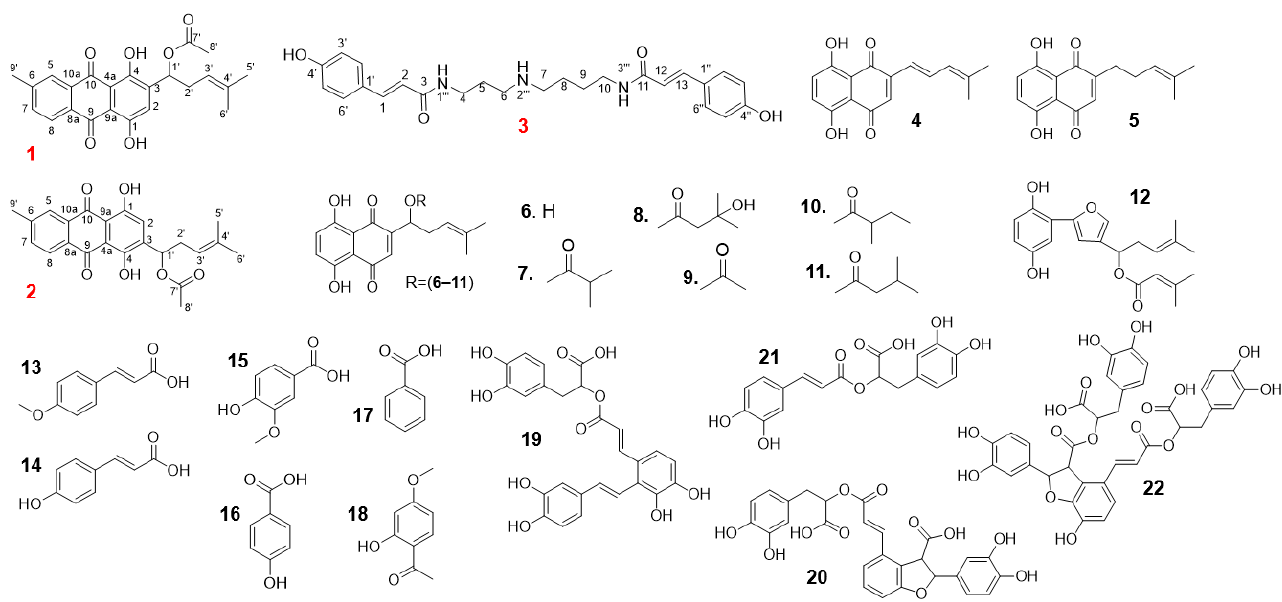
Figure 2. Structures of compounds isolated from L. erythrorhizon . Red, two novel compounds 1 , 2 , and one newly discovered compound from the Lithospermum genus 3 . Black, known compounds.